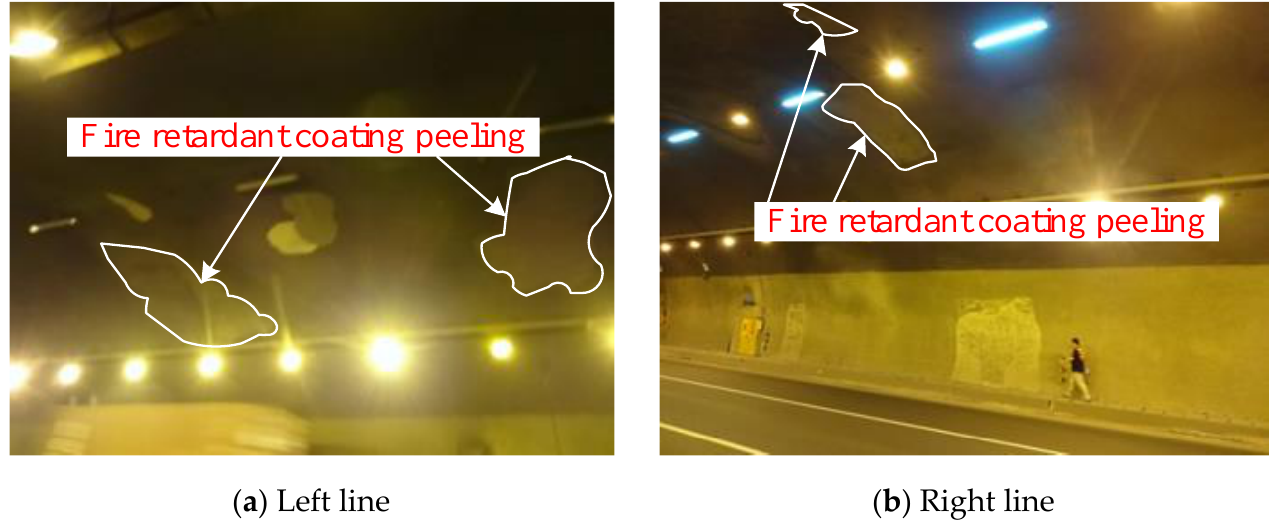
Figure 2. The scene of the peeling off of the fire-retardant coating.